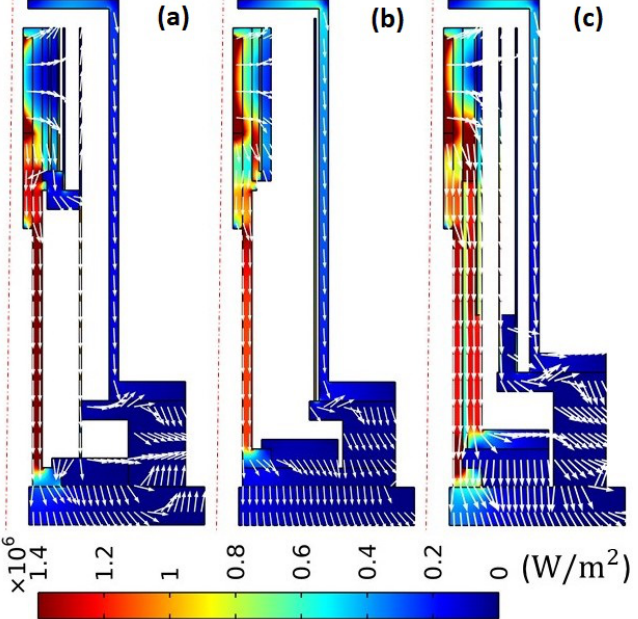
Figure 6. Heat Flux: ( a ) First conventional heater design, ( b ) Second conventional heater design, ( c ) Coaxial hollow cathode